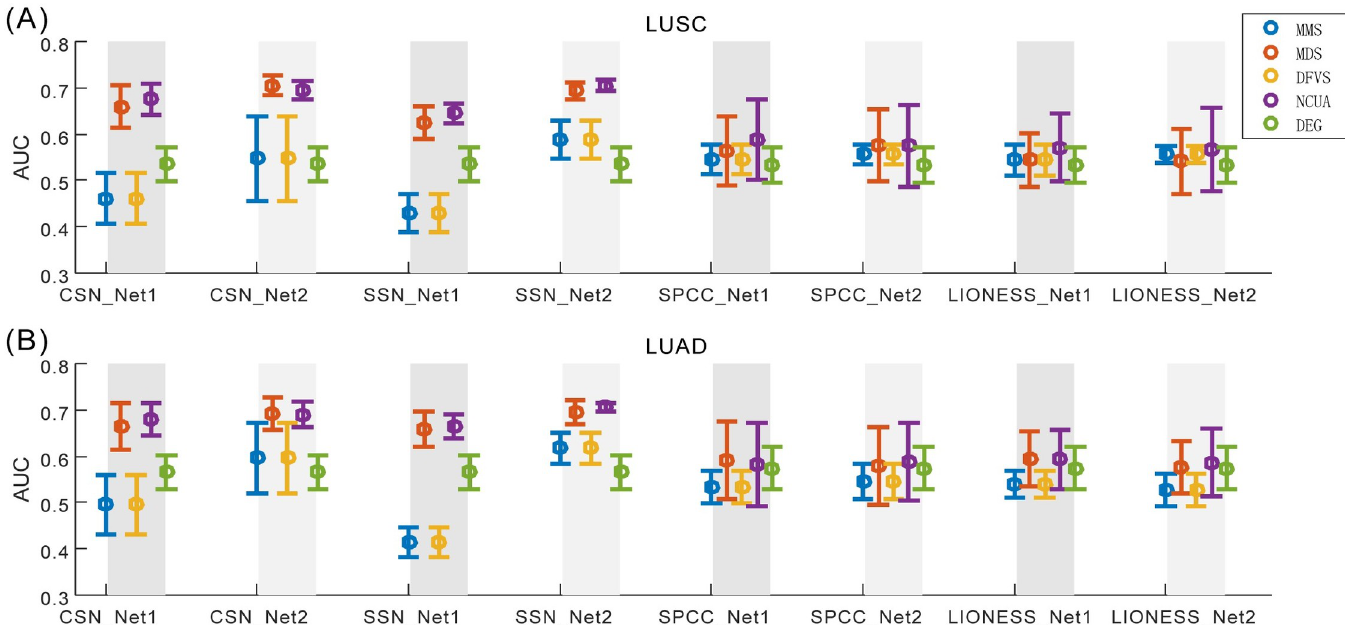
Fig 4. Evaluation of SSC workflows for drug target identification on LUSC and LUAD cancer datasets from TCGA. To evaluate the usage efficiency of sample-specific network drivers for personalized drug target discovery, the number of targeted sample-specific network drivers matching with drug combinations are calculated and anti- cancer drug target combinations are ranked for each patient. The drug combinations annotated in the Clinical Anti-cancer Combinational drugs (CAC) were applied to assess the AUC of the top-ranked/predicted anti-cancer drug combinations from different SSC workflows using (A) LUSC and (B) LUAD cancer datasets.